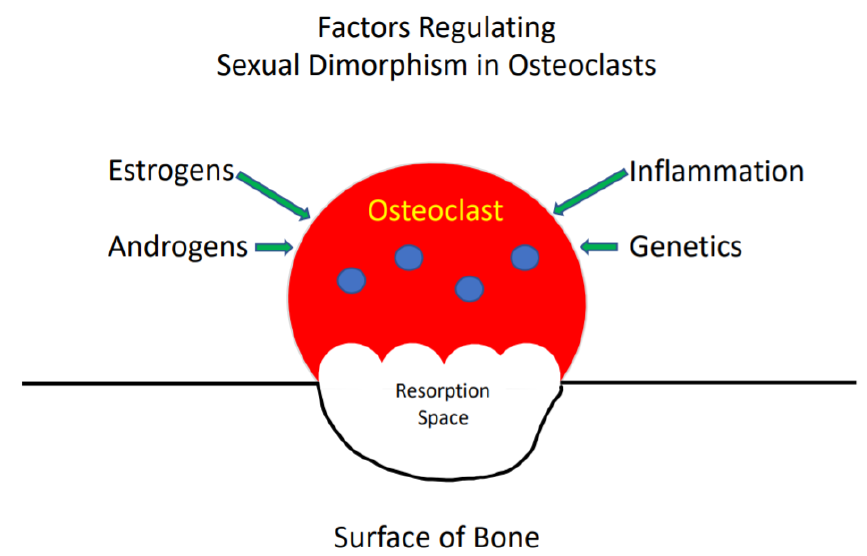
Figure 1. The reasons for the differences between women and men in the bone mass of the skeleton at various ages.